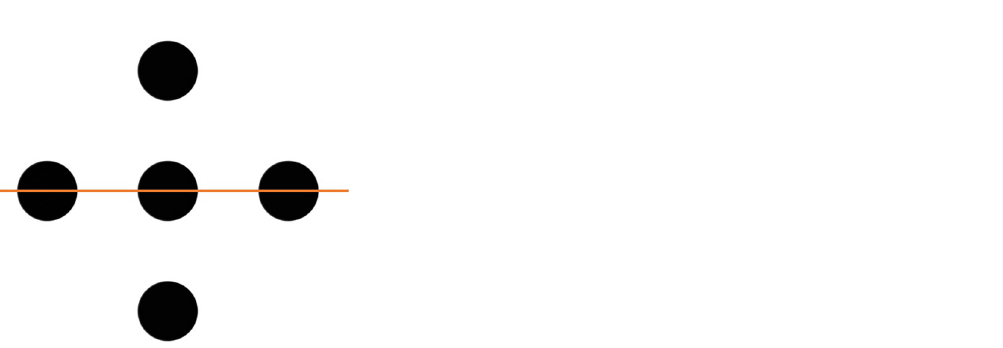
Figure 8. Overall view of the RCT imaging simulator.